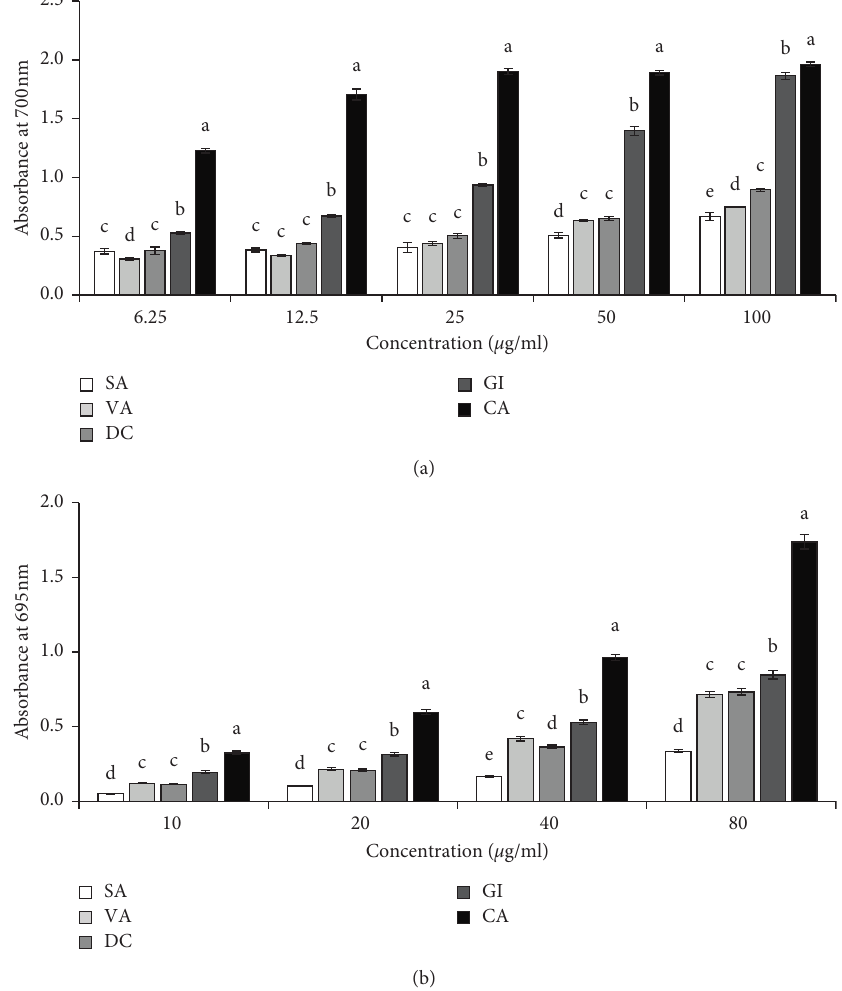
Figure 4: Reducing power and total antioxidant activities of the isolated compounds. (a) Reducing power. Absorbance (100 μ g/ml, 700nm): SA, 0.667 ± 0.035; VA, 0.746 ± 0.005; DC, 0.894 ± 0.014; GI, 1.865 ± 0.030; CA, 1.964 ± 0.019. (b) Total antioxidant activity. Absorbance (80 μ g/ml, 695nm): SA, 0.336 ± 0.009; VA, 0.716 ± 0.020; DC, 0.735 ± 0.022; GI, 0.848 ± 0.029; CA, 1.739 ± 0.049. Catechin (CA) was used as a reference antioxidant. Results represent mean ± SD ( n � 3). Compound 1 had no activity and was not shown. Means with different letters (a–e) differ significantly ( P < 0 . 05). SA, syringaldehyde; VA, vanillin; DC, dihydroconiferyl dihydro- p -coumarate; GI, gigantol;